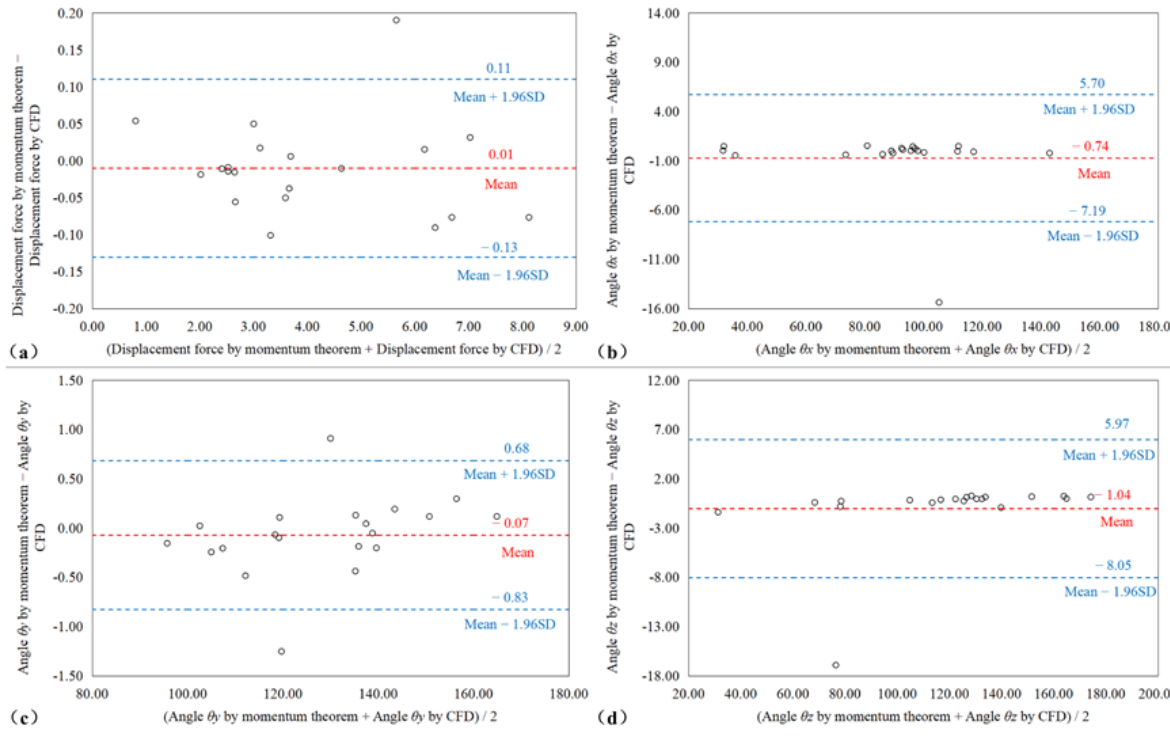
Figure 5. Bland–Altman diagram comparing the data consistency of ( a ) the displacement force, ( b ) θ x ,